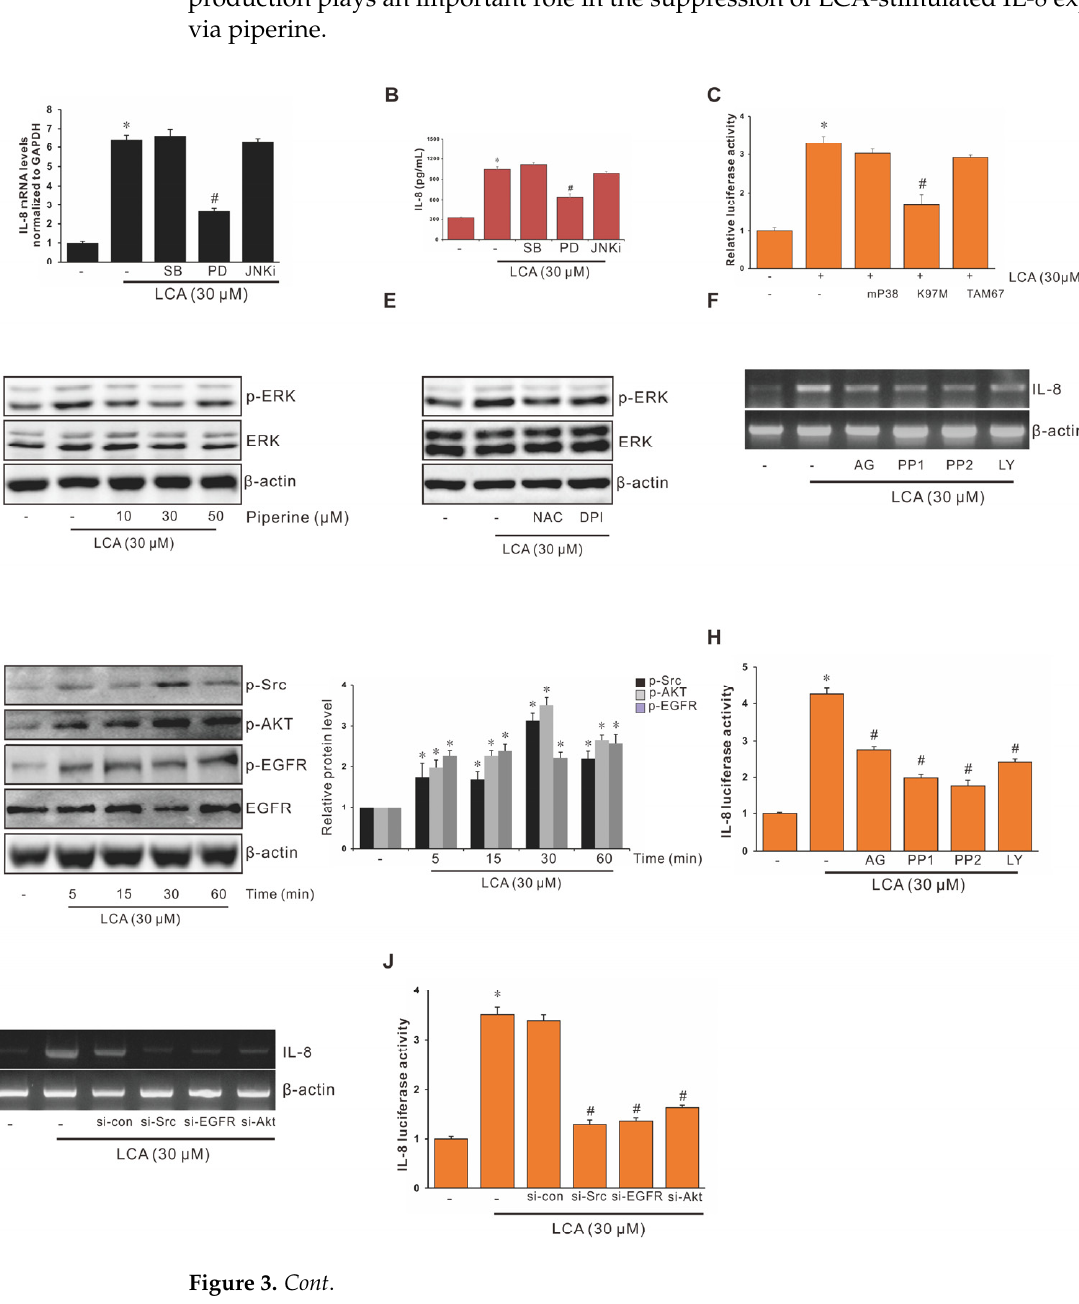
Figure 3. Piperine Inhibits LCA-Induced IL-8 Expression by Suppressing the Activation of ERK1/2, Src, AKT, and EGFR Signaling Pathways. ( A ) HCT-116 cells were pretreated with 30 μ M concentration of SB-203580 (SB), 30 μ M concentration of PD-98059 (PD), and 30 μ M concentration of JNKi for 1 h, and incubated with 30 μ M concentration of LCA for 4 h. Subsequently, the IL-8 mRNA level was measured through RT-qPCR. ( B ) HCT-116 cells pretreated with 30 μ M SB, 30 μ M PD, and 30 μ M JNKi for 1 h were incubated with 30 μ M LCA for 24 h followed by ELISA assay to determine the IL-8 expression level. ( C ) HCT-116 cells were transiently transfected with dominant- negative mutants of MEK-1 (K97 M), JNK (TAM67), or mutant p38 MAPK (mP38), and co- transfected with pGL2-IL-8. After incubation with 30 μ M LCA for 4 h, the luciferase activity was measured using a luminometer. ( D ) HCT-116 cells pretreated with 30 μ M SB, 30 μ M PD, or 30 μ M JNKi for 1 h were incubated with 30 μ M LCA for 4 h, and cell lysates were analyzed for the phosphorylated and total ERK level using western blotting. ( E ) HCT-116 cells pretreated with 5 mM NAC or 10 μ M DPI for 1 h were incubated with 30 μ M LCA for 4 h, and cell lysates were analyzed for the phosphorylated and total ERK level using western blotting. ( F ) HCT-116 cells were incubated with 30 μ M LCA for 0–60 min, and cell lysates were analyzed for levels of phosphorylated Src, AKT, and EGFR using western blotting. ( G ) HCT-116 cells pretreated with 10 μ M AG1478 (AG), 10 μ M PP1, 10 μ M PP2, and 20 μ M LY-294002 (LY) for 1 h were incubated with 30 μ M LCA for 4 h.